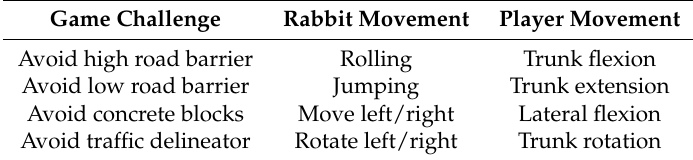
Rotate left/right Trunk rotation